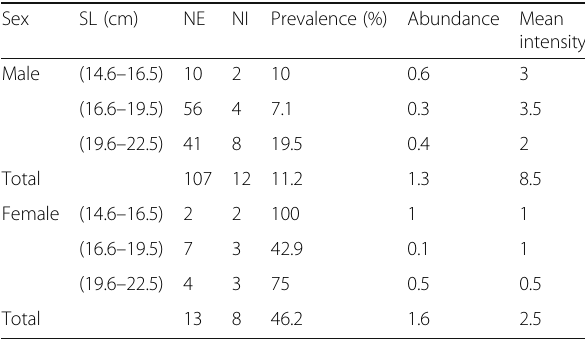
Table 2 Intensity of W . acuminata in S . clarias relative to standard